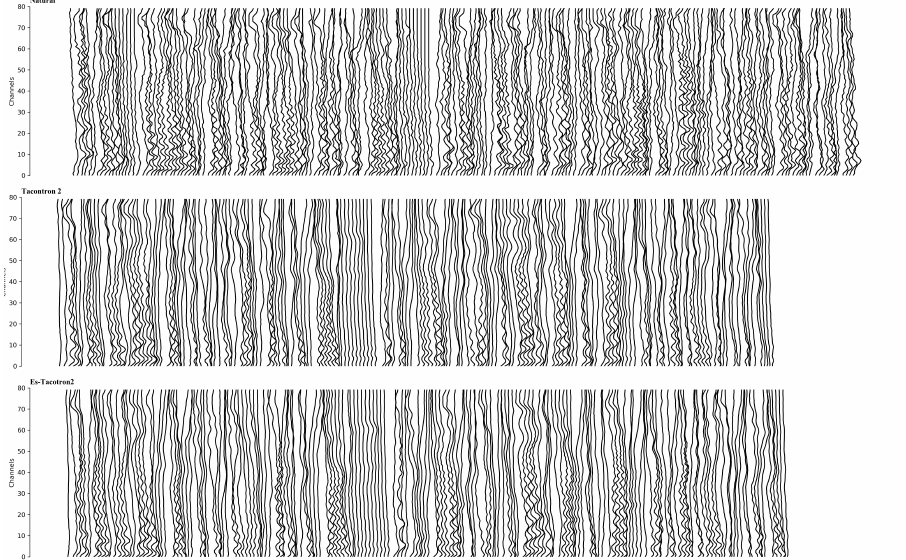
Figure 7. The spectrum sequence of synthesized spectrogram by original Tacotron 2, synthesized spectrogram by Es-Tacotron2 model and natural spectrogram without teacher-forcing